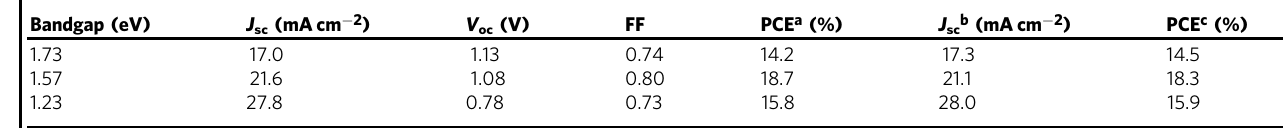
Table 1 Photovoltaic parameters of representative single-junction PSCs with different bandgaps. Bandgap